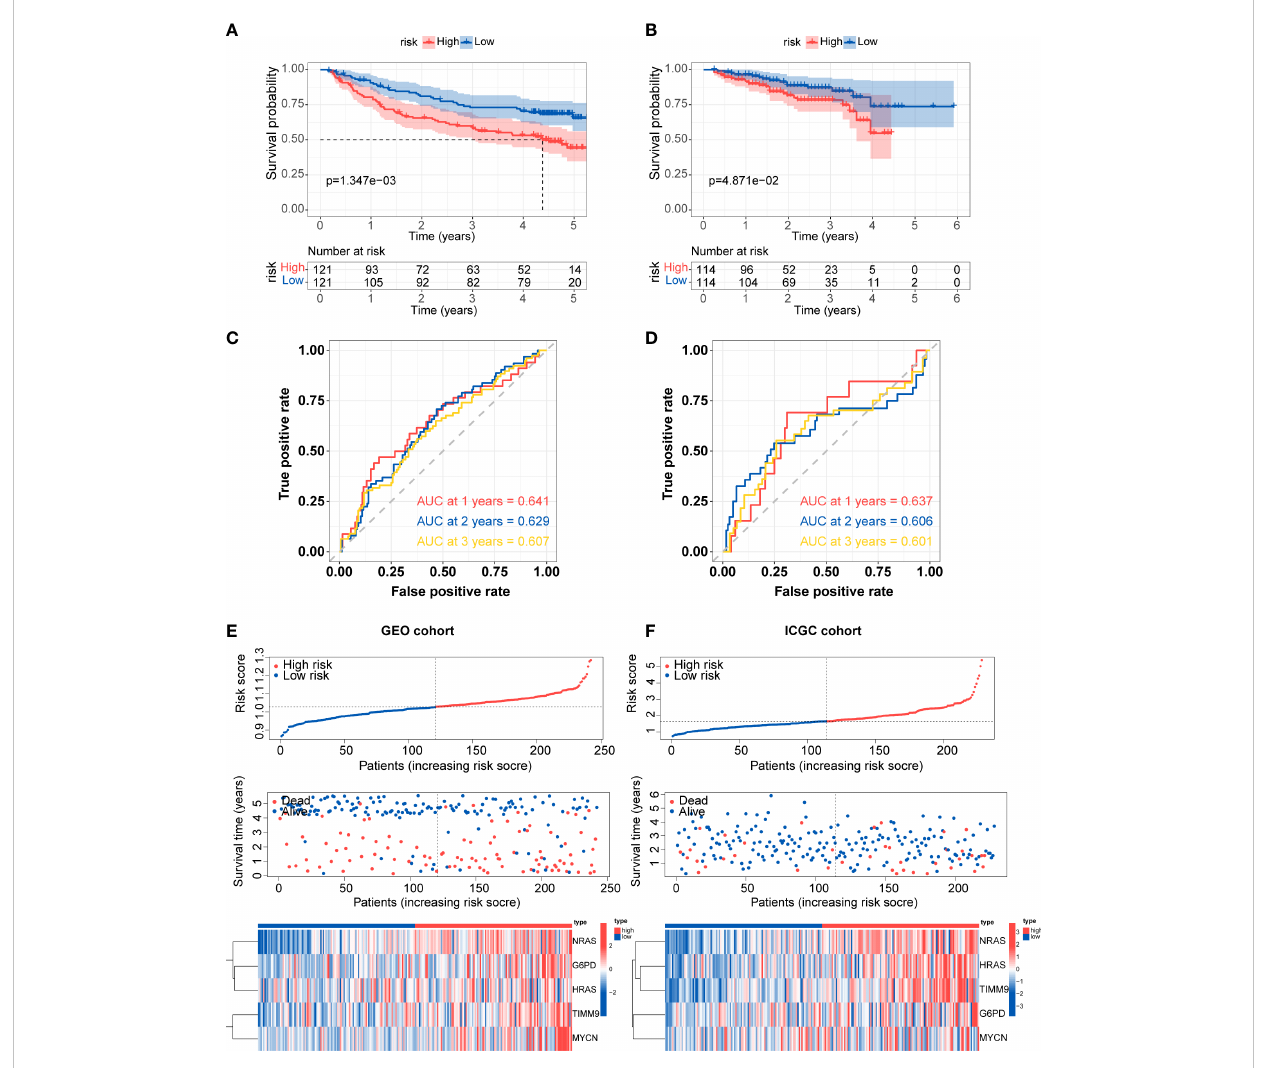
FIGURE 5 External validation of prognostic gene signature (A, B) Kaplan-Meier survival for overall survival in the two subgroups for the GEO cohort and ICGC cohort. (C, D) ROC curve veri fi ed the prognostic value of the risk model in the GEO cohort and ICGC cohort. (E, F) Distribution of risk score, correlation between the survival time and survival status of each patient, and the heatmaps of this signature expressions in the GEO cohort and ICGC